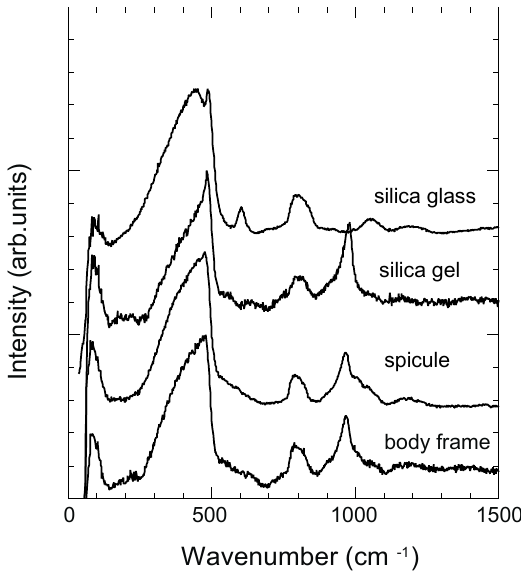
Figure 6. Raman spectra ( ν = 50–1500 cm − 1 ) for body frame, spicule, silica gel, and silica glass.